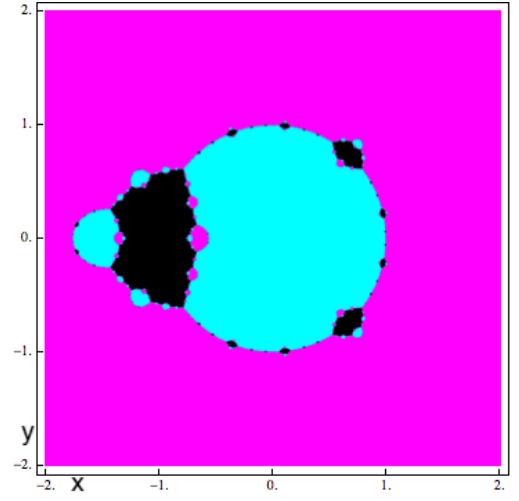
Figure 4. Basins of attraction associated with the member r = − 5 and t =